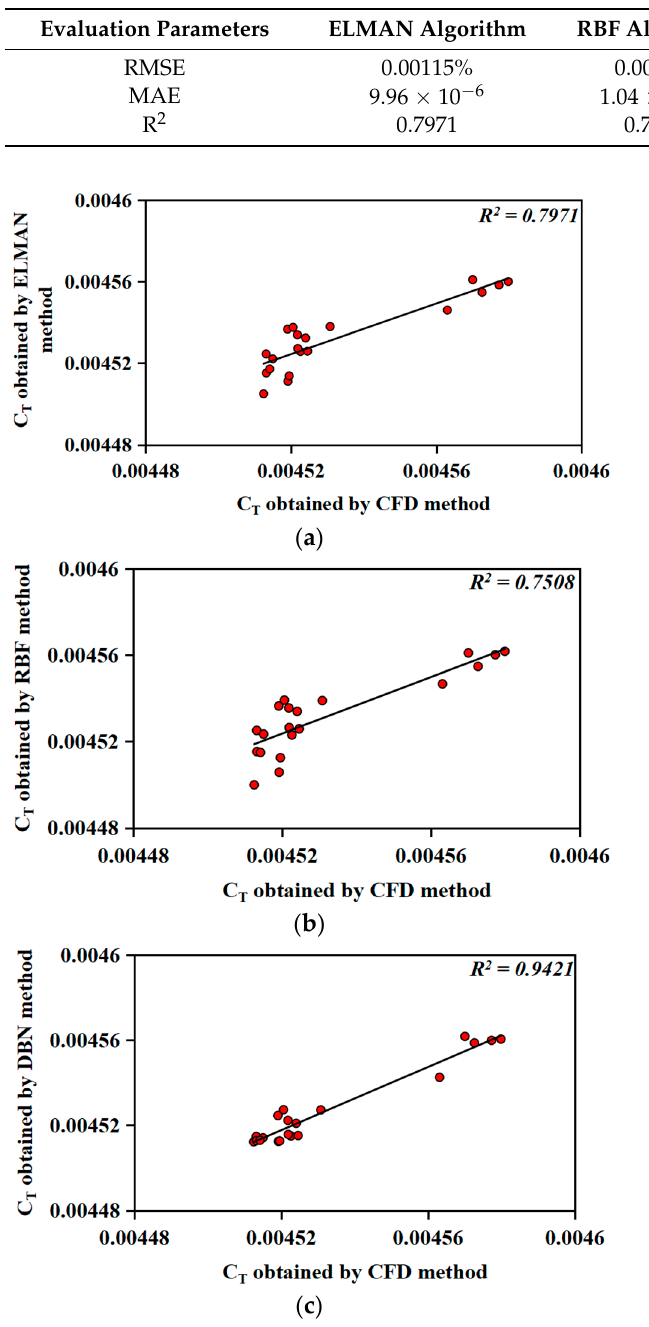
Table 4. A comparison of RMSE and MAE and R 2 for the total resistance coefficient prediction.